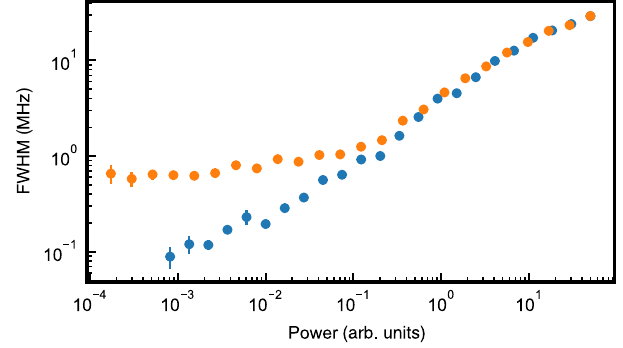
FIG. 17. Effect of persistent spectral hole burning on the homogeneous linewidth. The homogeneous linewidth is mea- sured using the scheme described above. In the first curve (blue), the laser frequency is changed randomly after each iteration of the transient-hole-burning sequence. If the laser frequency is not shifted (orange), broader lines are obtained at low laser powers, which is attributed to persistent spectral hole